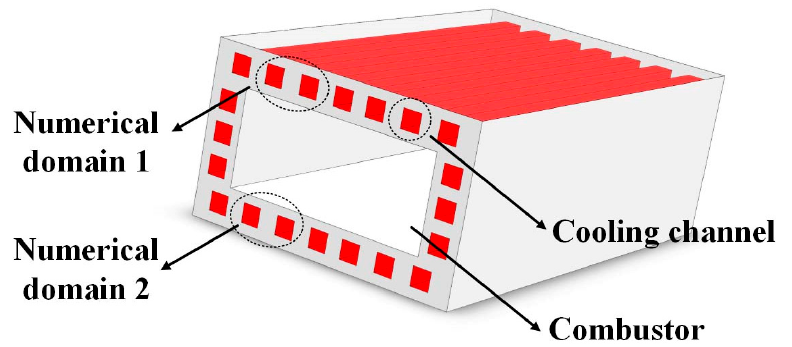
Figure 1. Schematic cross-sectional view of a typical scramjet cooling channel.